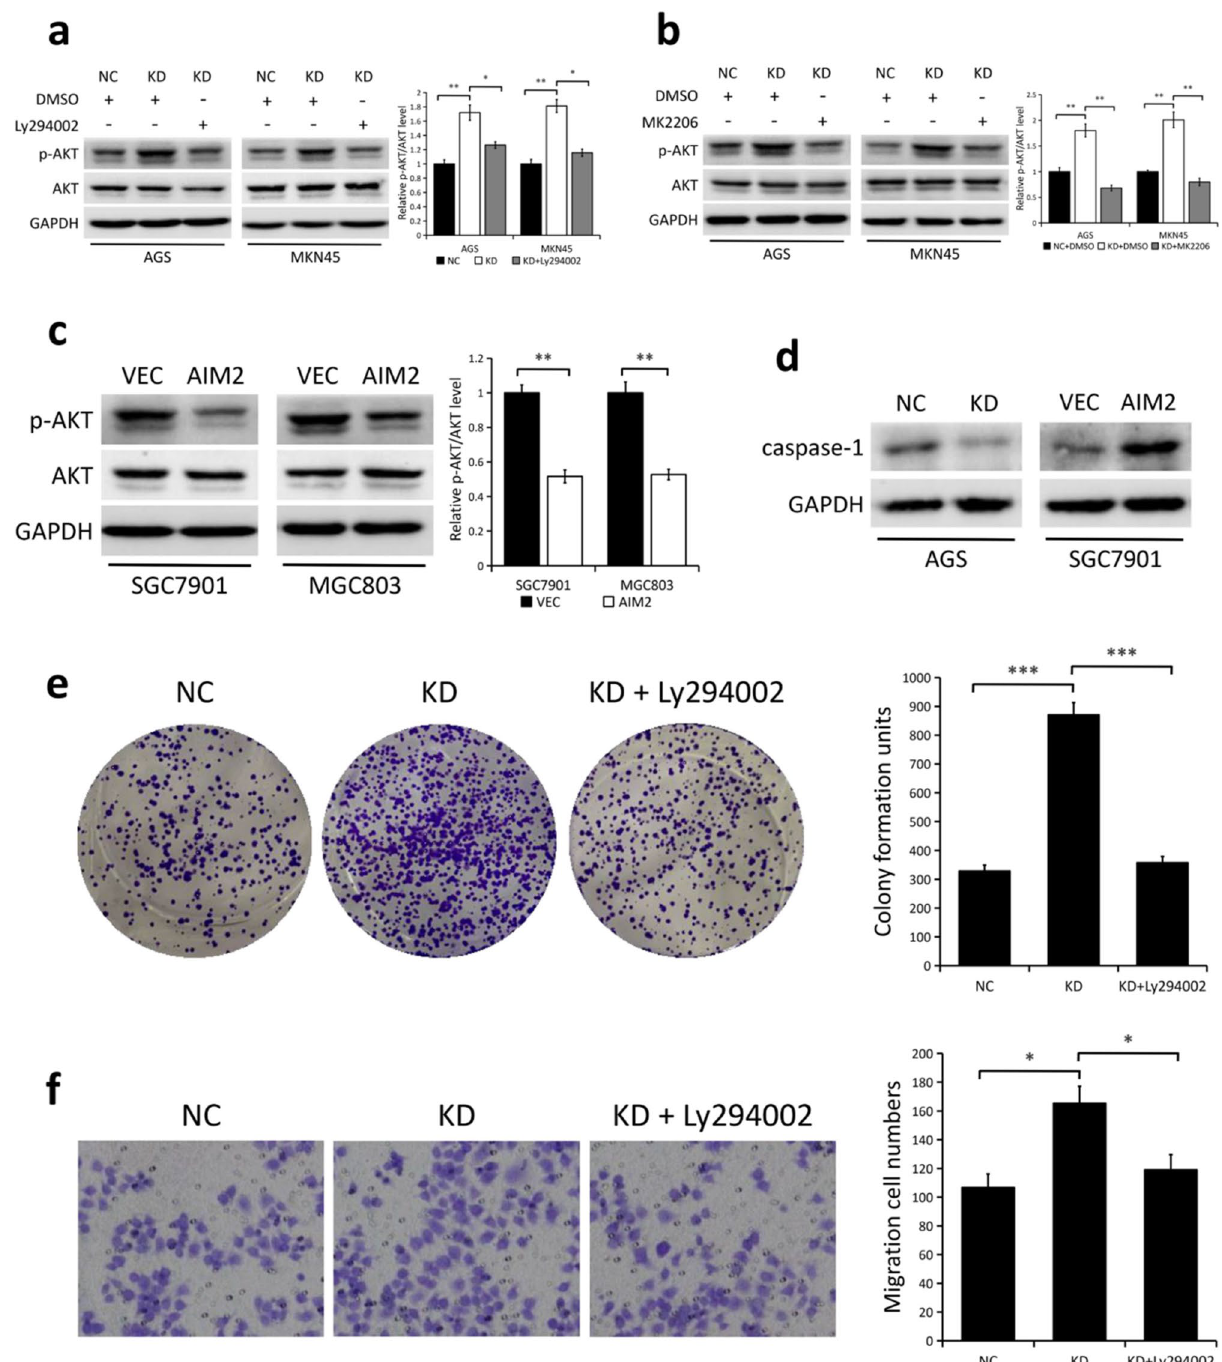
Figure 4. AIM2 inhibits GC cell proliferation and migration in an AKT-dependent manner. ( a , b ) Immunoblotting of the indicated proteins in wild-type AGS and MKN45 cells (NC) and in cells with stable knockdown of AIM2 (KD) with or without treatment of Ly294002 ( a , 20 μM) or MK2206 ( b , 5 μM). DMSO treatment is considered as the control group. GAPDH as a loading control. ( c ) Immunoblotting of the indicated proteins in wild-type SGC7901 and MGC803 cells (VEC) and in cells with stable overexpression of AIM2 (OE). GAPDH as a loading control. ( d ) Immunoblotting of caspase-1 in AGS cells (NC vs. KD) and SGC7901 cells (VEC vs. AIM2). GAPDH as a loading control. ( e ) Colony formation assays were performed in AGS cells (NC vs. KD) in the presence or absence of Ly294002, and the relative number of colonies was quantified (right). Error bars, mean ± SEM from three biological replicates. ( f ) Migration assays were performed in AGS cells (NC vs. KD) in the presence or absence of Ly294002, and the migratory cells number was quantified (right). Error bars, mean ± SEM from three biological replicates. The proteins were quantified using the ImageJ software (version: 1.4.3). * P < 0.05; ** P < 0.01; *** P < 0.001. The original Western blots are included in the Supplementary Fig.